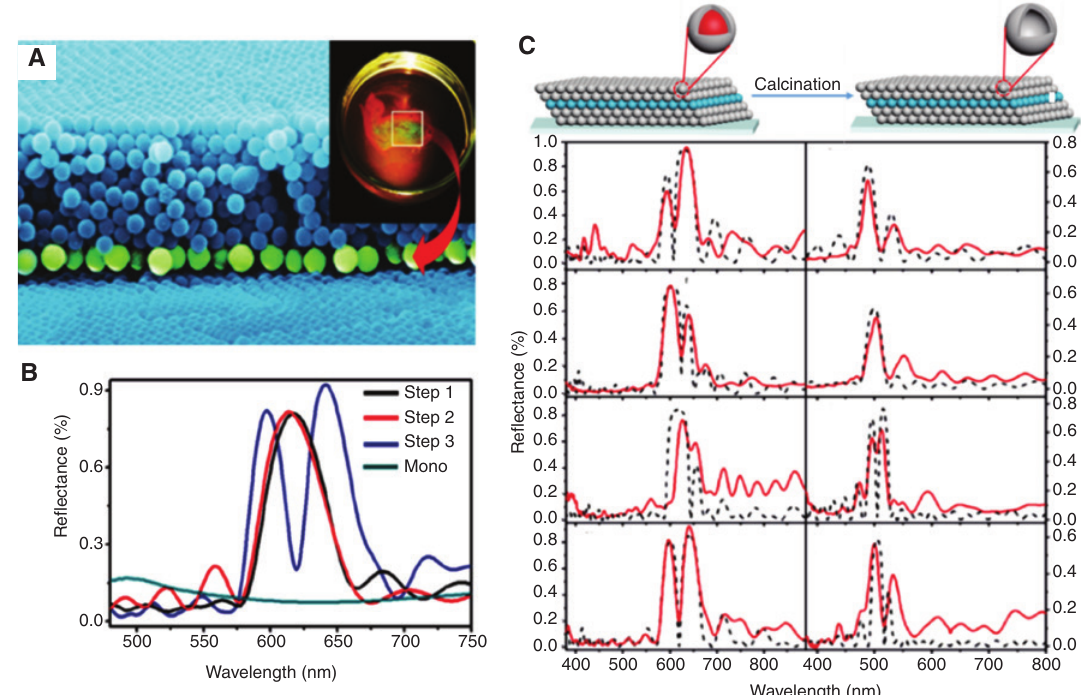
Figure 5: Introduction of a planar defect into CPCs for pronounced passband. (A) A typical SEM image of sandwiched CPCs with a defect layer as indicated by the green color. (B) Reflectance spectra of different fabrica- tion steps, in which steps 1, 2, and 3 represent the bottom CPC consisting of PS@SiO spheres, after deposition of the defect layer on the 2 surface of the bottom CPC, and after deposition of the second CPC, respectively. (C) Experimental (solid) and simulated (dashed) reflectance spectra from a series of sandwiched CPCs with various thicknesses of defect layer. Left column, PS@SiO core-shell spheres as building 2 blocks. Right column, hollow SiO spheres as building blocks obtained after calcination. Adapted with permission from ref. [109], COPY- 2 RIGHT 2014 The Royal Society of